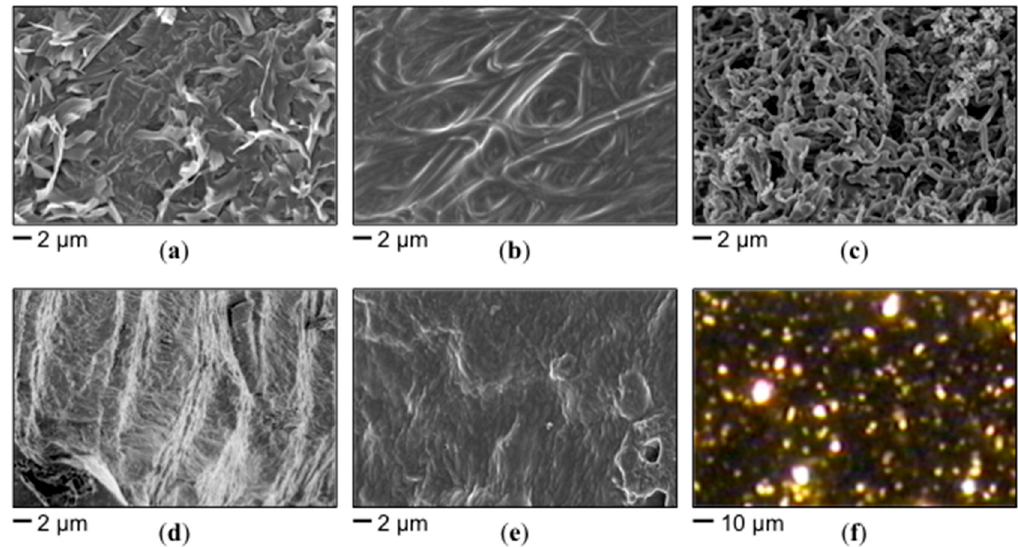
Figure 5. Representative FE-SEM photographs of xerogels prepared by freeze-drying the organogels made of 14 in ( a ) ethyl acetate (5 g/L); ( b ) benzonitrile (35 g/L); ( c ) 1,4-dioxane (50 g/L); ( d ) toluene (9 g/L); ( e ) dichloromethane (29 g/L); ( f ) birefringent domains visualized under polarized light for the xerogel derived from the gel made of 14 in dichloromethane (29 g/L).